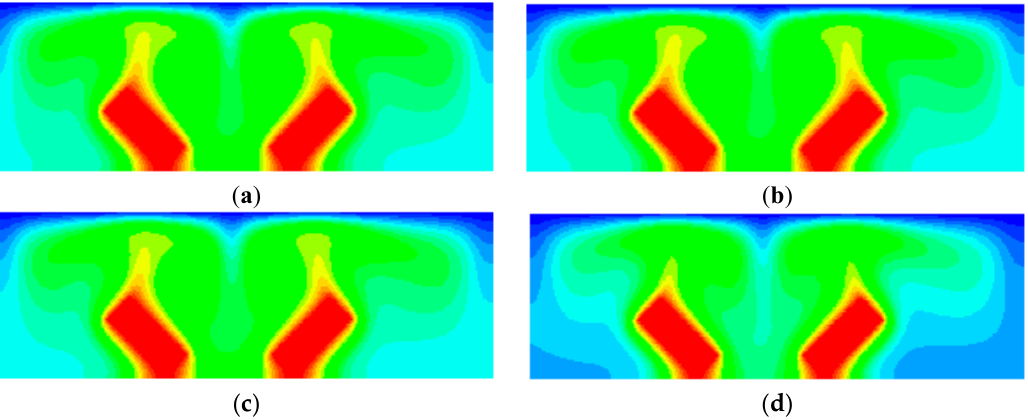
Figure 13. Isothermal dusty contours under the effects of mixture densities ratio at inclination angle 𝛾 (cid:2869) = 45 ° , 𝜙 (cid:3002)(cid:3039) = 𝜙 (cid:3004)(cid:3048) = 0.02,𝛼 (cid:3046) = 0.001,𝑅𝑎 = 10 (cid:2873) , at 𝐿 (cid:2869) = 𝐿 (cid:2870) = 0.5 and 𝛾 = 0.1 . ( a ) 𝐷 (cid:3046) = 1 ; (cid:3118) (cid:3016) (cid:3119) ( b ) 𝐷 (cid:3046) = 10 ; ( c ) 𝐷 (cid:3046) = 100 ; ( d ) 𝐷 (cid:3046) = 1000